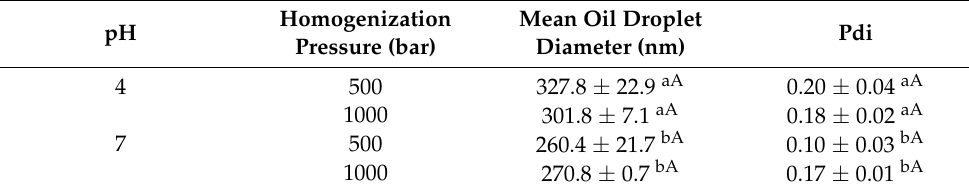
Table 2. Mean oil droplet diameter and polydispersity index (Pdi) of O/W emulsions stabilized by WPI at different pH and elaborated at different homogenization pressures.